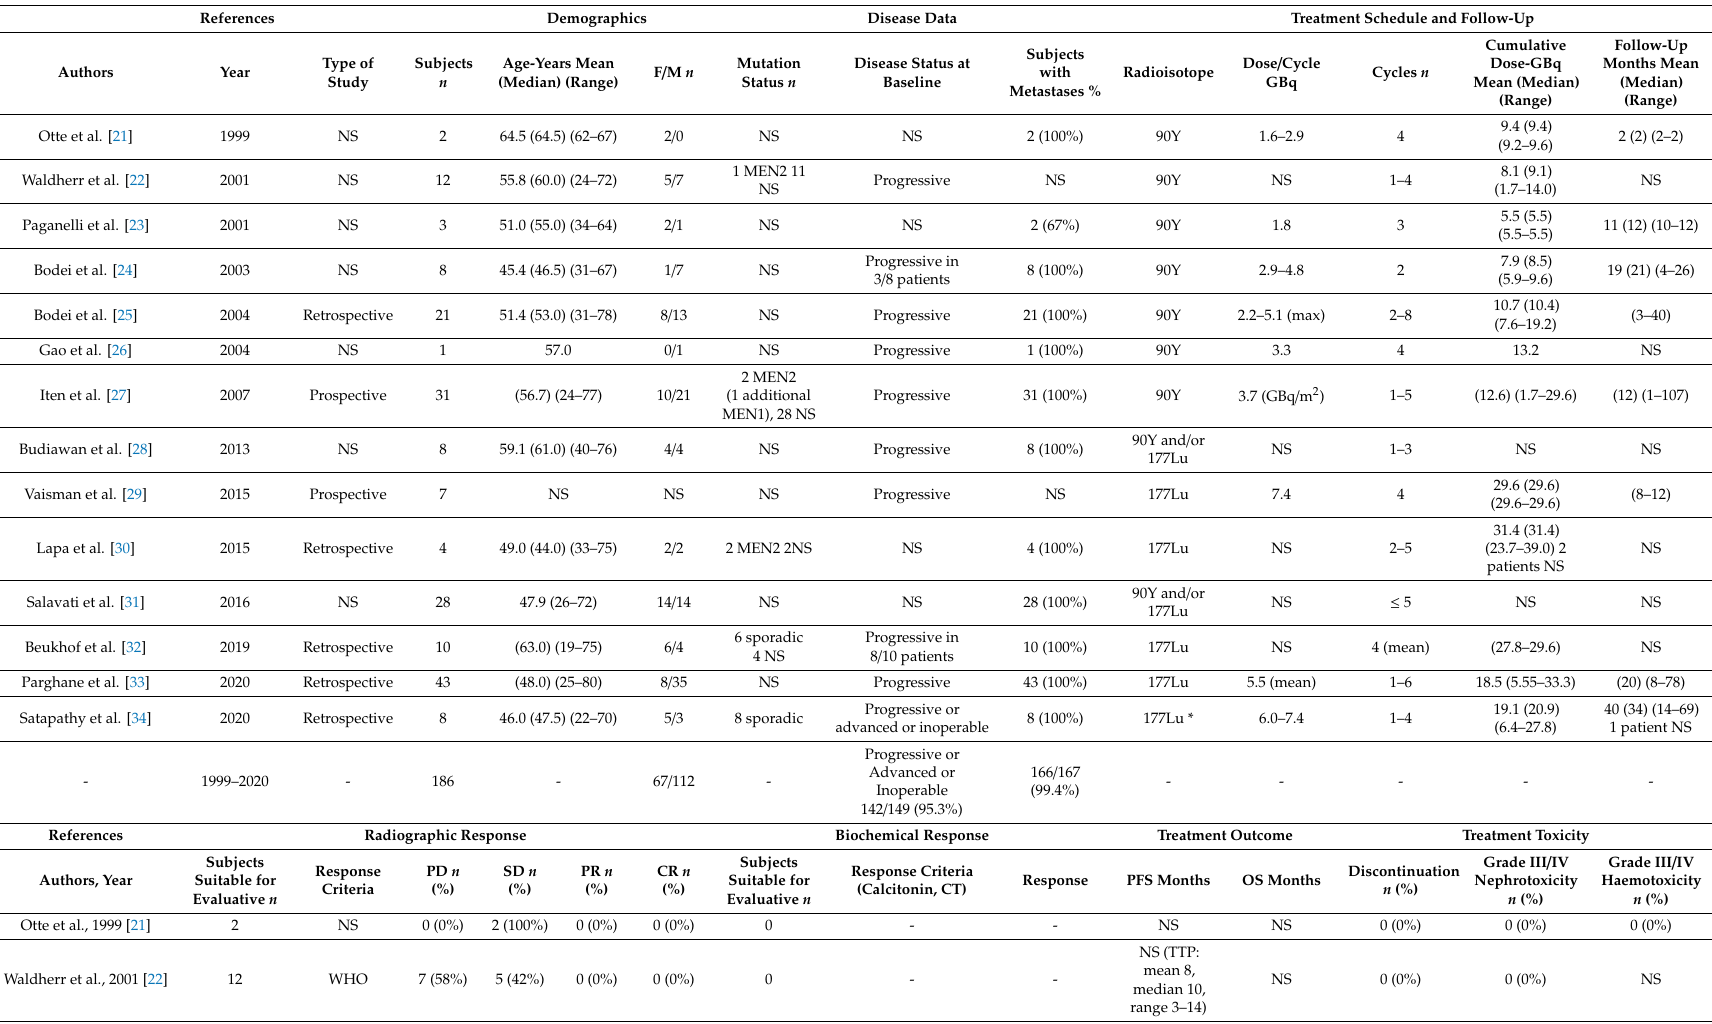
Table 1. PRRT targeting SSRs with 90Y and 177Lu-SSA in